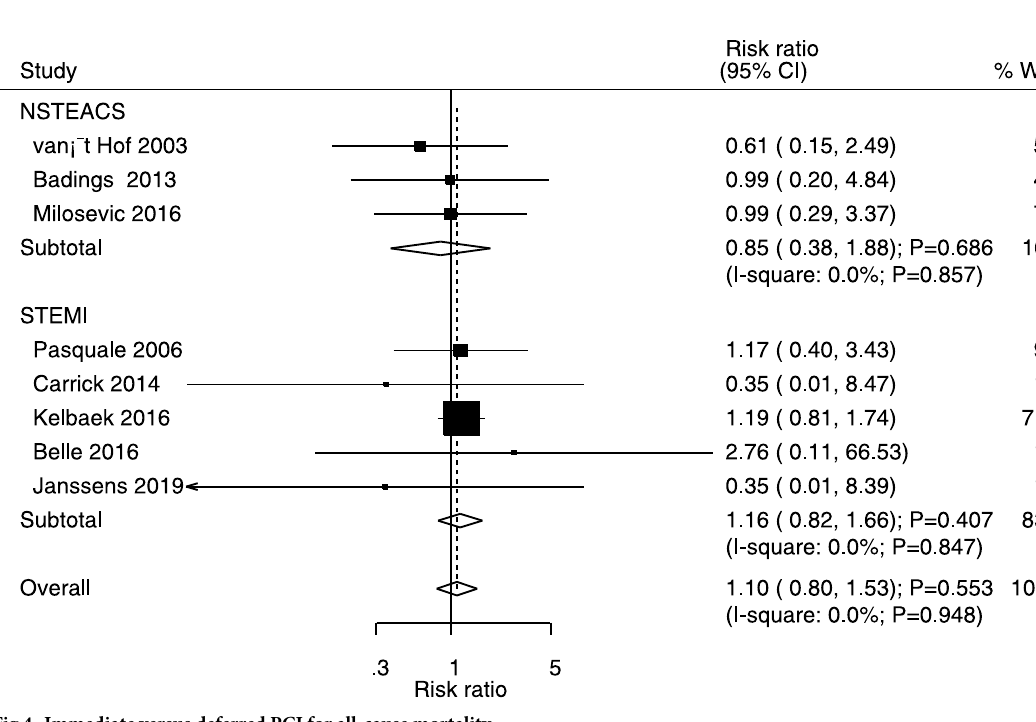
Fig 4. Immediate versus deferred PCI for all-cause mortality.